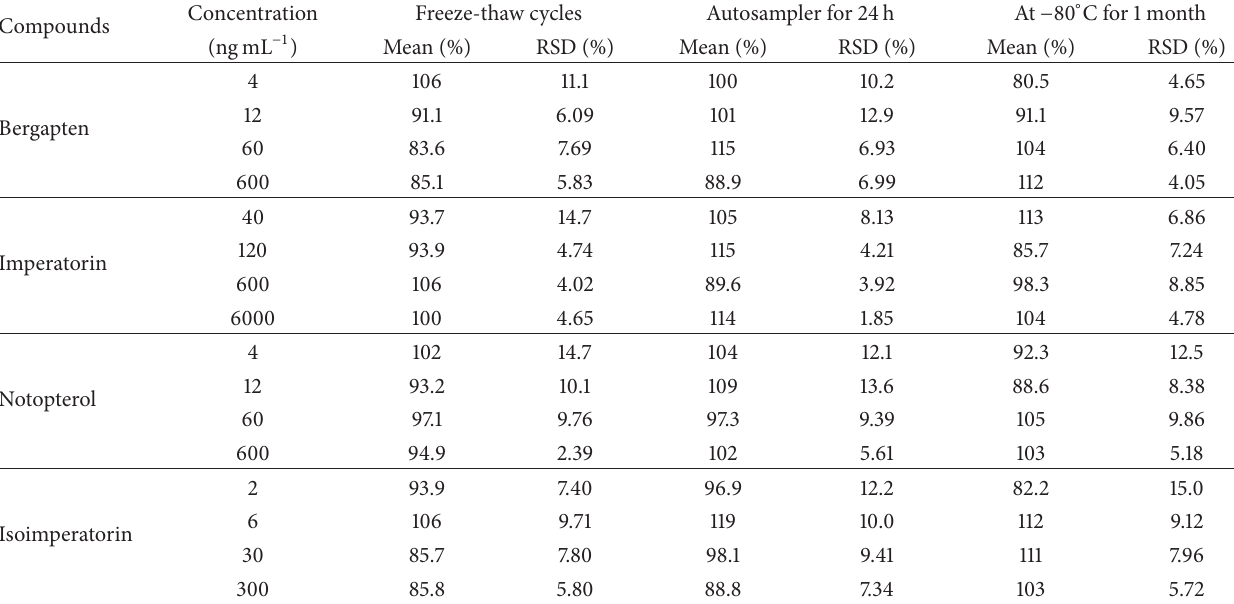
Table 4: Stability of bergapten, imperatorin, notopterol, and isoimperatorin in rat plasma ( 𝑛 = 6 ).